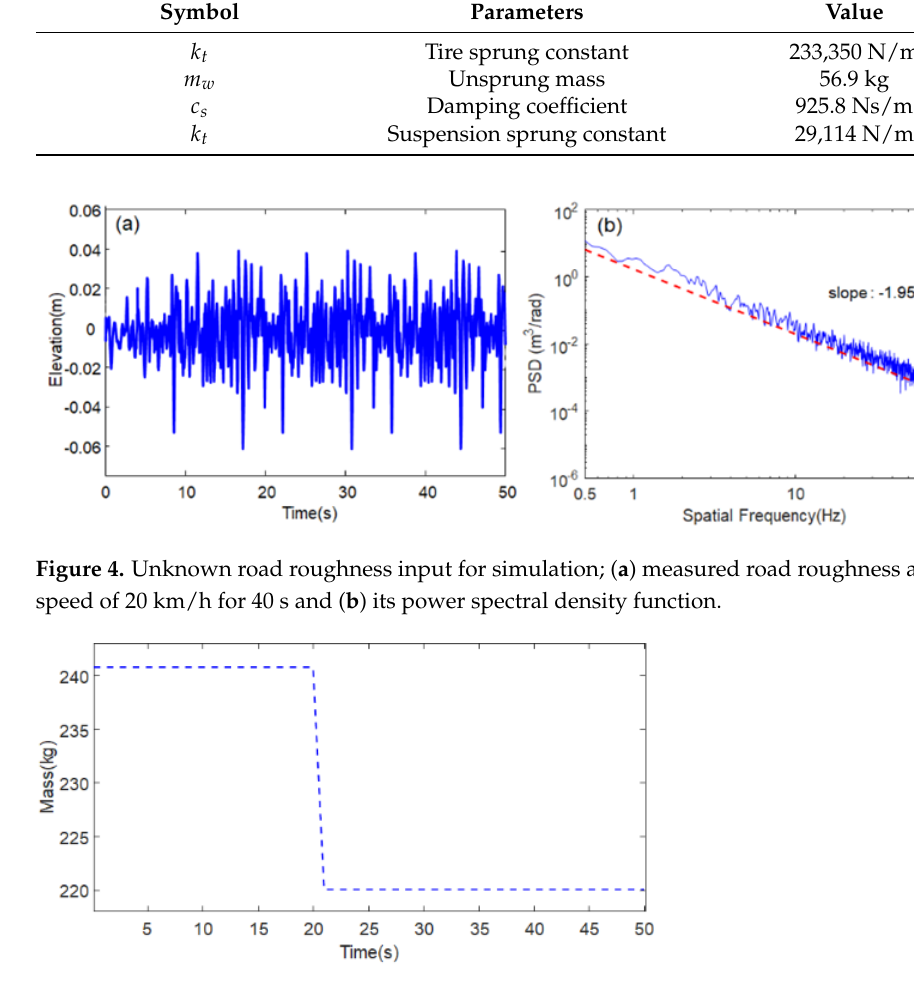
Figure 5. Sudden drop scenario of vehicle mass around 20 s (240 kg → 220 kg).